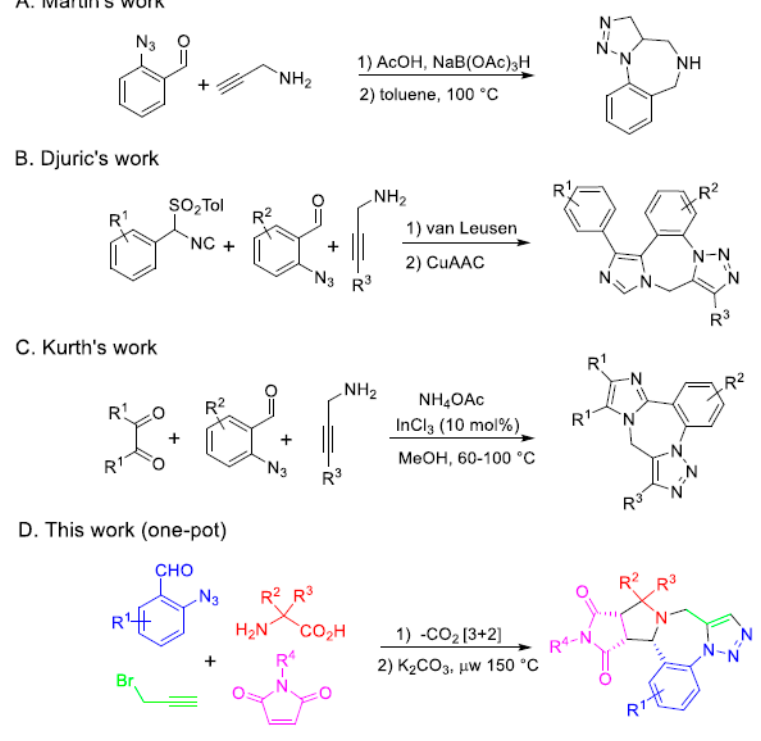
Scheme 1. Atom economic synthesis of triazolobenzodiazepines.